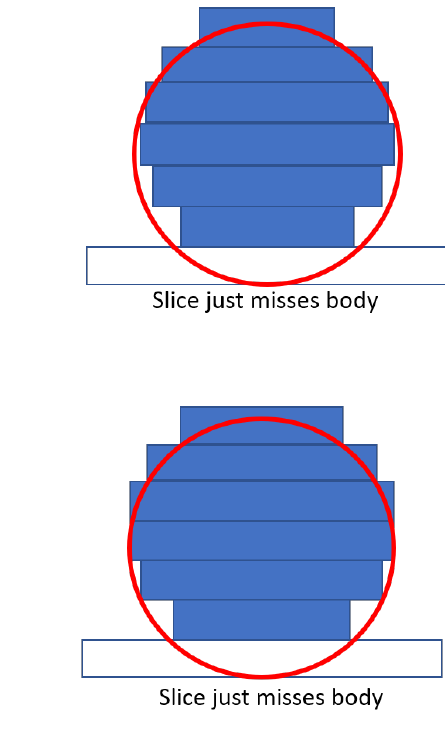
Figure 6. Naive slicing.